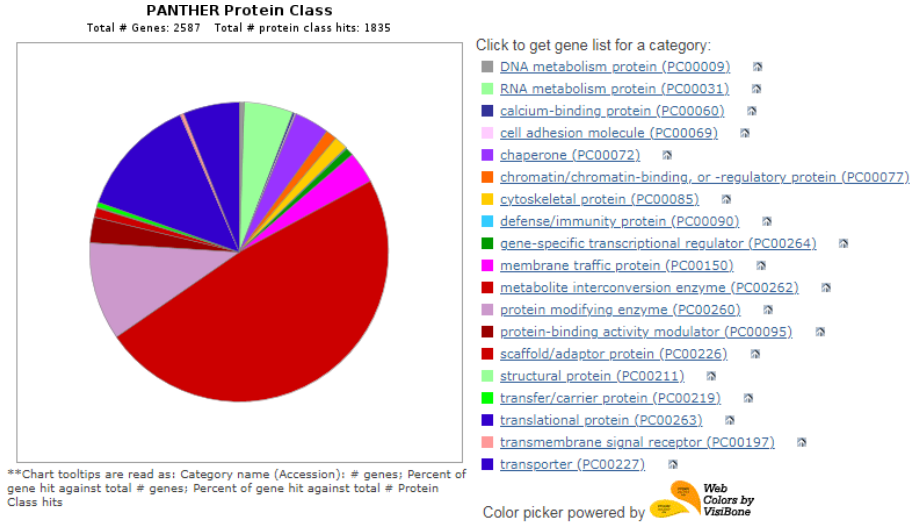
Figure 10. Gene Ontology classification of proteins in HBGH35 and Pusa Naveen ( ♀ ) based on their molecular function and metabolic interconversion enzymes.